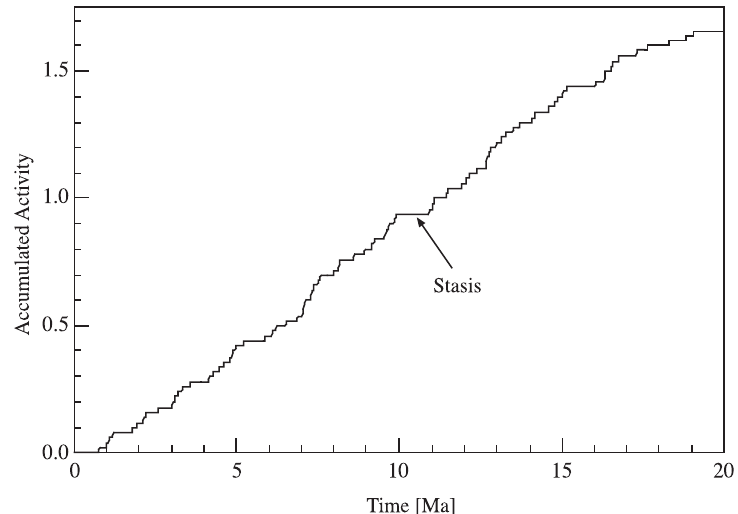
Fig. 4. The Devil’s staircase for the geomagnetic polarity time series resulting from the Accumulated Activity AA ( t